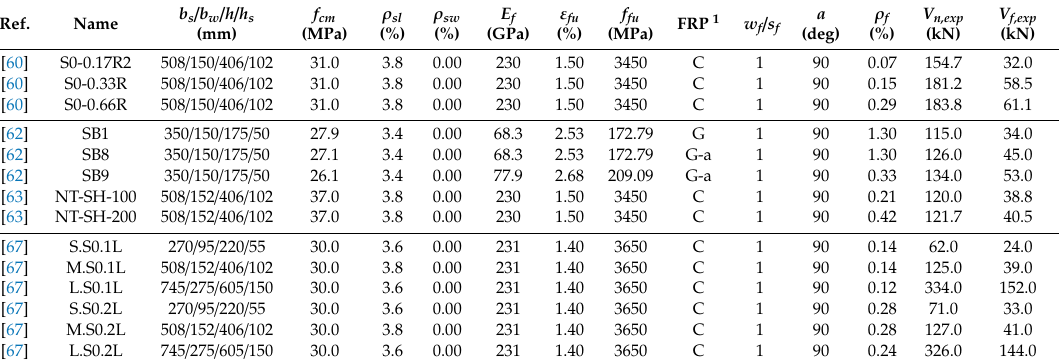
1 C: Carbon; G: Glass; A: Aramid; -a: with additional anchorage. Table A3. Properties of the retrofitted T-beams with EB-FRP U-strips and stirrups of the database.